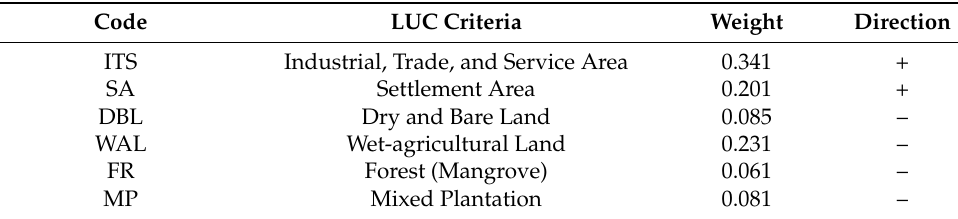
Table 4. List of Weight for each Criterion. Code LUC Criteria Weight Direction ITS Industrial, Trade, and Service Area